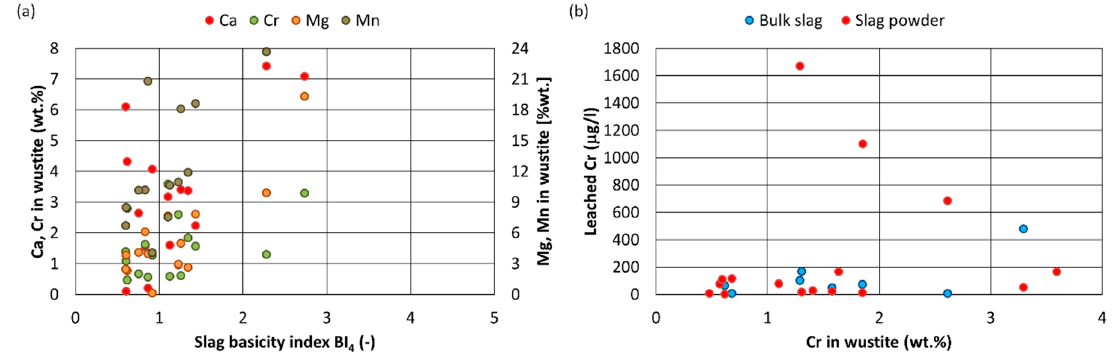
Figure 10. Cr, Ca, Mn and Mg distribution within Mg-wustite as a function of slag basicity ( a ) and effect of Cr concentration within Mg-wustite on Cr leaching ( b ).